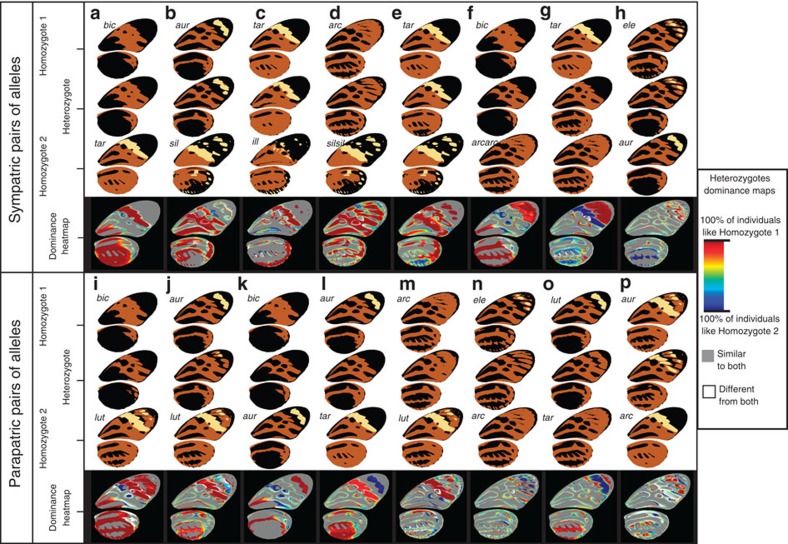
Dominance heat maps for all pairs of alleles.Upper and lower panels present sympatric (a–h) and parapatric (i–p) pairs of alleles, respectively. Each column (a–p) shows, for a given pair of alleles, the modal wing patterns of homozygous dominant (top), heterozygote (middle) and homozygous recessive (bottom) genotypes on a white background, and the corresponding dominance heat map on a black background. Each heat map pixel is coloured on a scale from red to blue representing the proportion of heterozygous individuals identical to one (red or blue), both (grey) or neither homozygote (white). Areas displaying a rainbow of colours are due to variations in patch size and shape among heterozygotes. Alleles are referenced with the first three letters of each mimetic form (bic: bicoloratus; aur: aurora; arc: arcuella; ele: elegans; lut: lutea; tar: tarapotensis; sil: silvana; ill: illustris).